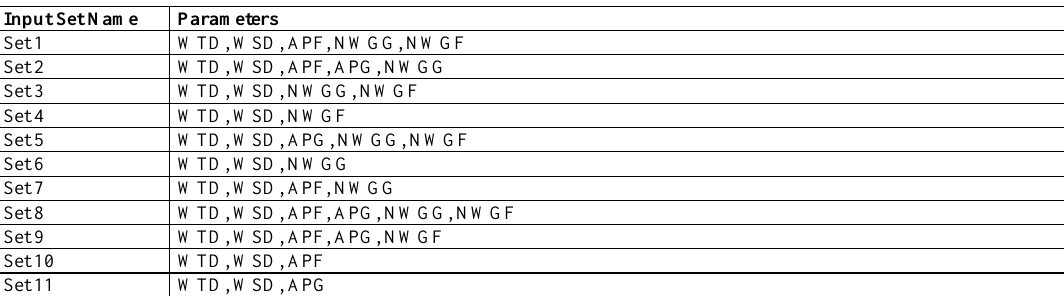
Figure 3. Pareto chart of the MLR model. Table 2. Input set